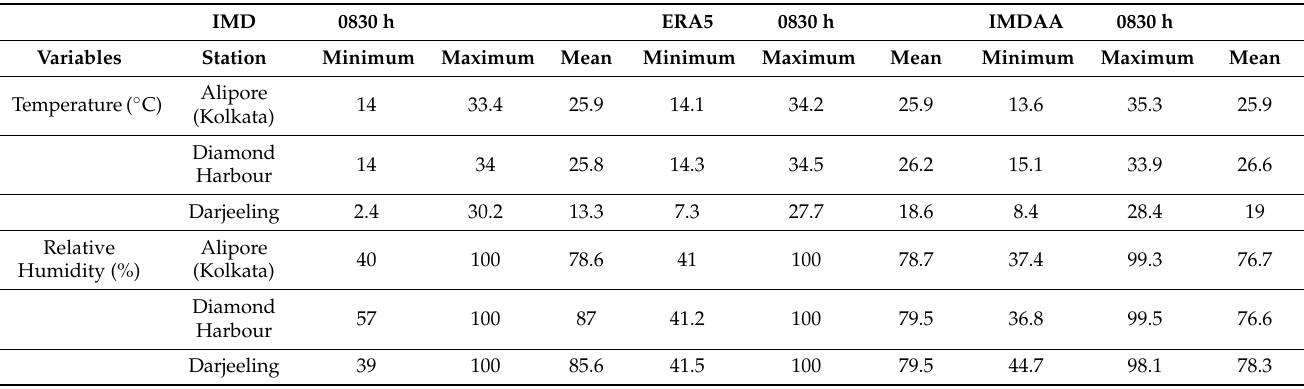
Figure 5. PET and temperature differences for each month under RCP4.5 and RCP8.5 from CORDEX during 2080–2099 relative to the reference period (1986–2005). The abbreviations of all investigated stations are described in Table 1. Table 3. Comparison of the descriptive statistics for temperature, relative humidity, wind speed, and cloud cover from ERA-5, IMDAA, and IMD. PET has been calculated by RayMan using daily data from 2020 to 2021 at 0830 h (IST). Three stations, namely Alipore (Kolkata), Diamond Harbour, and Darjeeling, have been chosen for this comparative